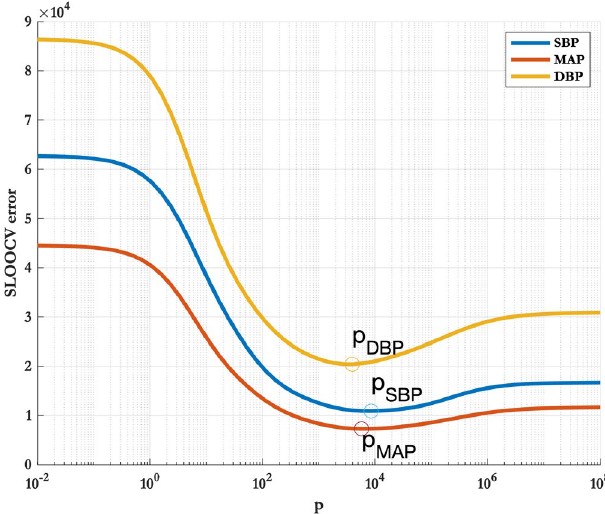
Figure 11. Determining p SBP , p MAP and p DBP by minimising SLOOCV across all volunteers in the dataset. The optimum values of p SBP , p MAP and p DBP are labelled.